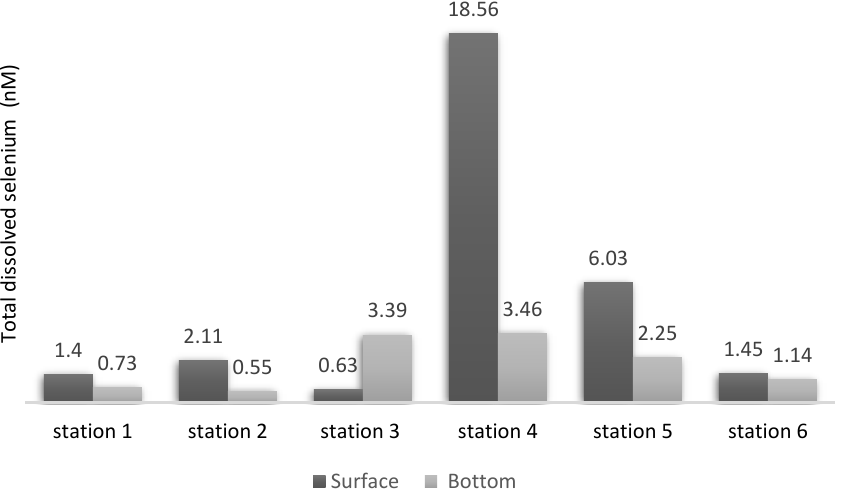
Figure 2. Distribution of the total dissolved selenium in the surface and bottom water of Al-Arbaeen Lagoon.